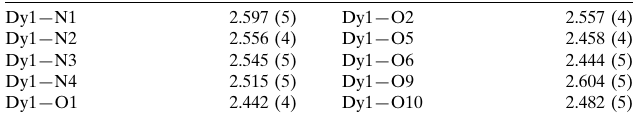
Selected bond lengths (A˚ ).